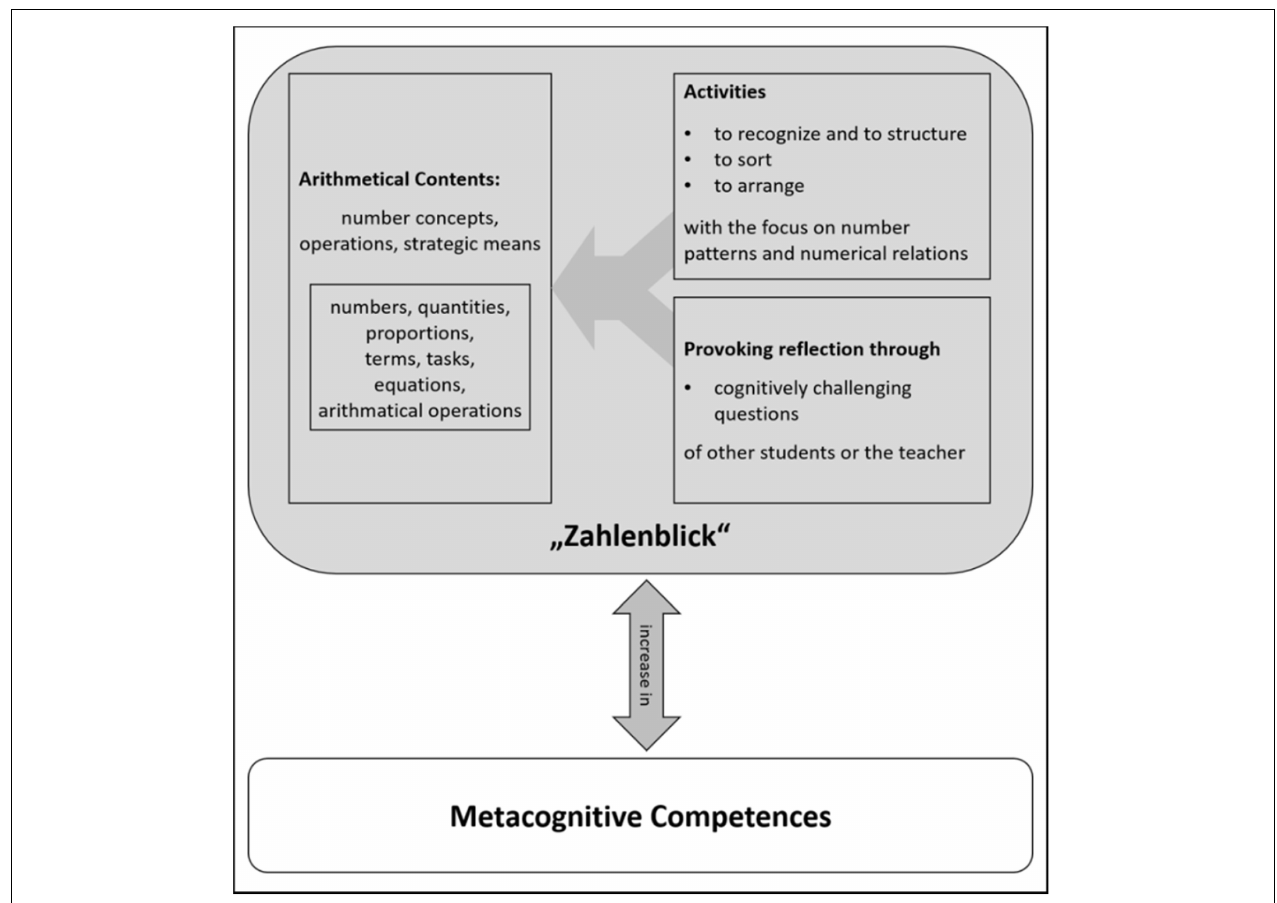
FIGURE 3 | Model for the development of “Zahlenblick” (modified in accordance with Rechtsteiner-Merz, 2013, p. 103).